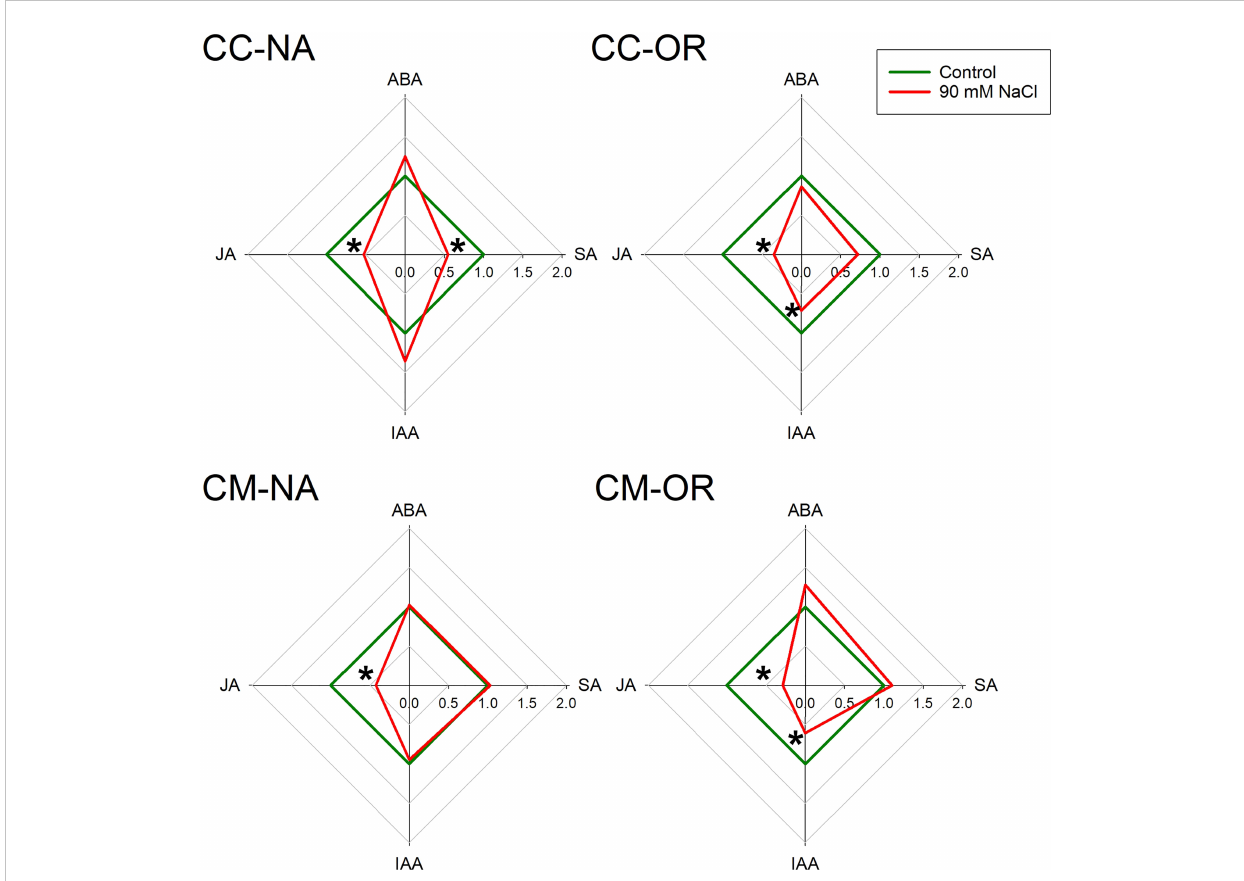
FIGURE 6 Root phytohormone content. Radar plots with root relative content of abscisic acid (ABA), jasmonic acid (JA), salicylic acid (SA), and indole acetic acid (IAA) in control (green lines) and 90 mM NaCl stressed plants (red lines) of CC-NA, CC-OR, CM-NA, and CM-OR after 30 days. Data are mean of three replicates. Asterisks denote statistically signi fi cant differences between control and salt-stressed plants of each scion/rootstock combination at p ≤